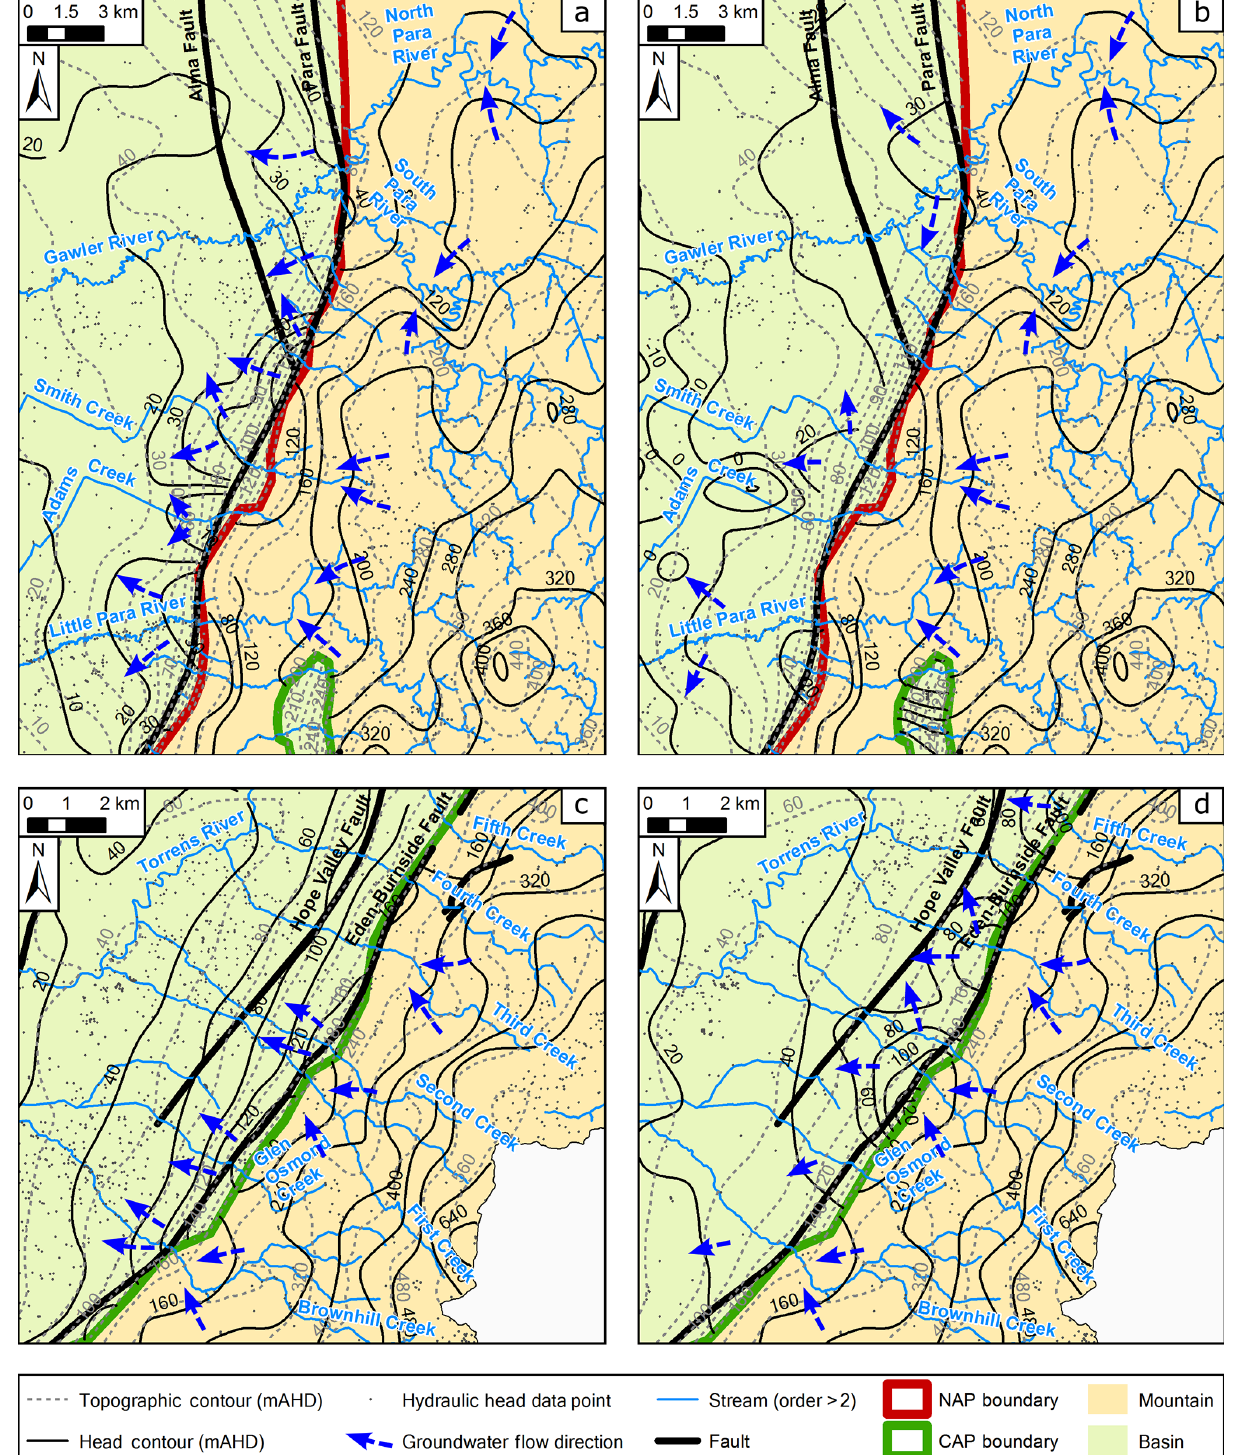
Figure 9. Hydraulic head and topographic contours in the NAP (a–b) and CAP (c–d) focus areas. On the basin side, (a) and (c) show the head in the Quaternary aquifers, while (b) and (d) show the head in the Tertiary aquifers. On the mountain side, all four sub-figures show the head in the Mount Lofty Ranges aquifers. In (a–b) , the contour interval is 10m in the basin and 40m in the mountain (both for head and topography), while in (c–d) , it is 20m in the basin and 80m in the mountain. Selected groundwater flow directions highlight apparent gaining stream conditions in the lower part of the mountain and loosing stream conditions in the mountain-front